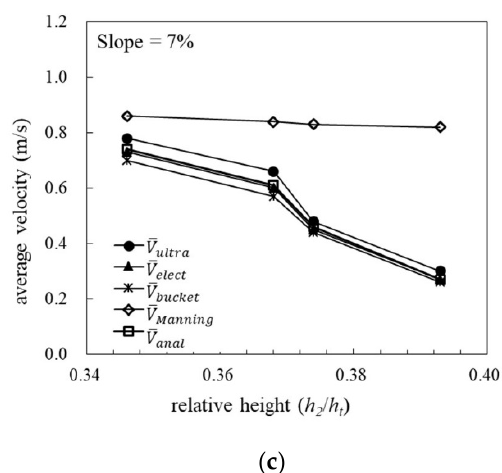
Figure 5. Average flow velocities at different relative heights for Carpet grass with bed slopes of ( a ) 3.5%, ( b ) 6%, and ( c ) 7%.